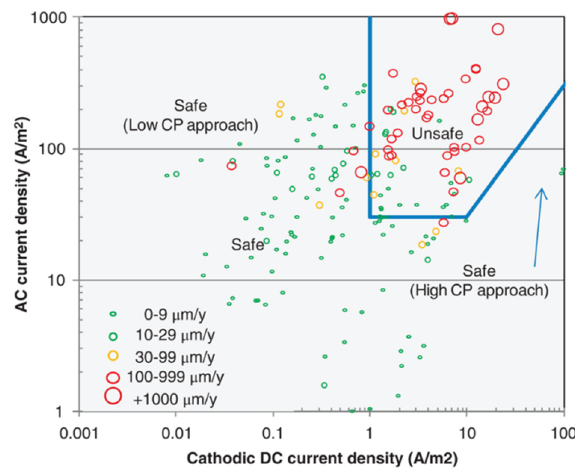
Figure 10. AC corrosion rate measured on corrosion coupons as reported by Nielsen [63]. Data are compared with the AC protection criteria reported in ISO 18086.